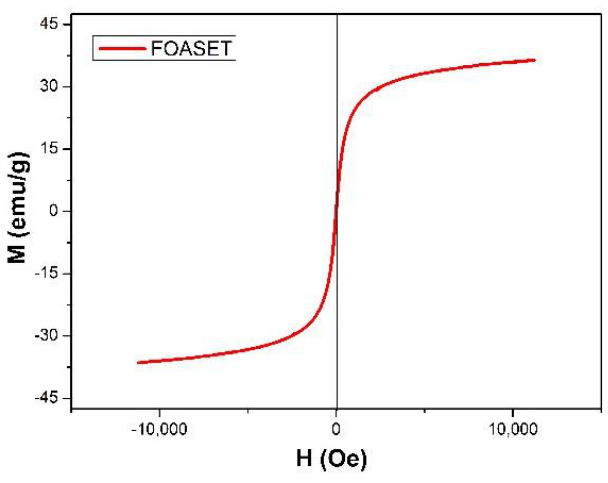
Figure 7. Magnetic hysteresis loops of FOASET nanoparticles. Figure 8 exhibits the UV–VIS spectra of FOA and FOASET nanoparticles, respectively. From UV–Vis absorption spectra, the FOA NC shows an SPR peak at 531 nm that was attributed to Au nanoparticles (curve a). The multifunctional FOASET NC exhibits a broad absorption band extending from the UV–VIS to the NIR region. In curve b, two peaks at 262 nm and 345 nm are related to the absorption characteristics of the Eu(TTA) 3 complex. They correspond to intramolecular charge transfer (ICT) of TTA ligands and a TTA ligand to europium(III) charge transfer, respectively. The broad absorption band from 400 nm to 900 nm induced by SPR of the Au nanoparticles layer with a peak at 528 nm was also obviously observed. The broad optical absorption of the synthesized multifunctional FOASET nanoparticles allows them to overcome the limitation of UV excitation of rare earth ions and makes them potentially useful for photothermal